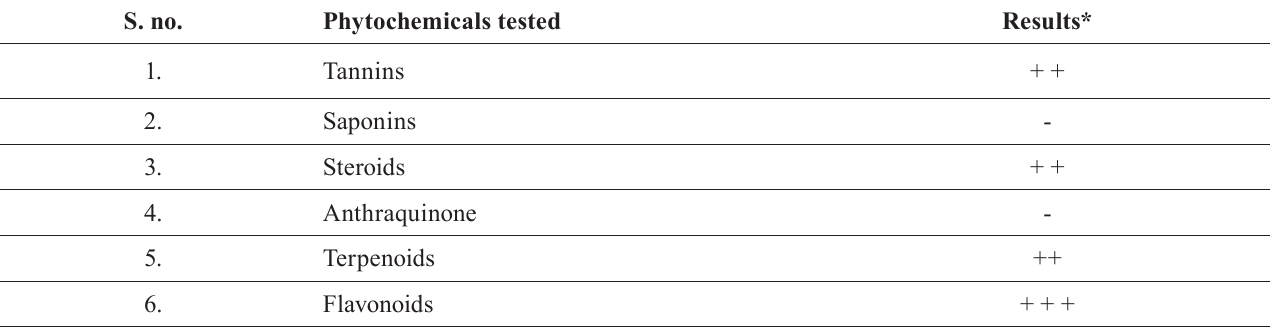
TABLE II - Phytochemical constituents of methanol extracts of M. arvensis Linn S.